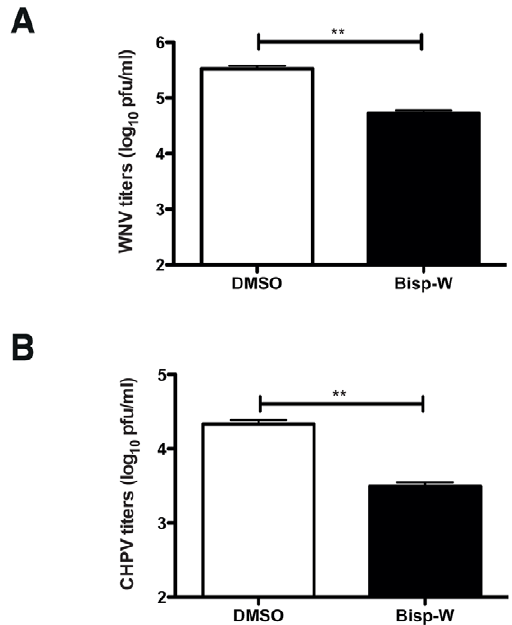
Figure 6. Effect of Bisp-W on other encephalitic viruses. (A) N2A cells were infected with an MOI of 1 pfu/cell with WNV and treated with DMSO or 5 m M of Bisp-W. Viral titers in cell culture supernatants (22 h pi) were determined by plaque assay. (B) N2A cells were infected with an MOI of 0.1 pfu/cell with CHPV and treated with DMSO or 5 m M of Bisp-W. Viral titers in cell culture supernatants (8 h pi) were determined by plaque assay. Error bars represent Mean 6 SEM of three replicates. Data are representative of two experiments performed with triplicate samples. **P=004 and 0.002 respectively as determined by unpaired, two-tailed